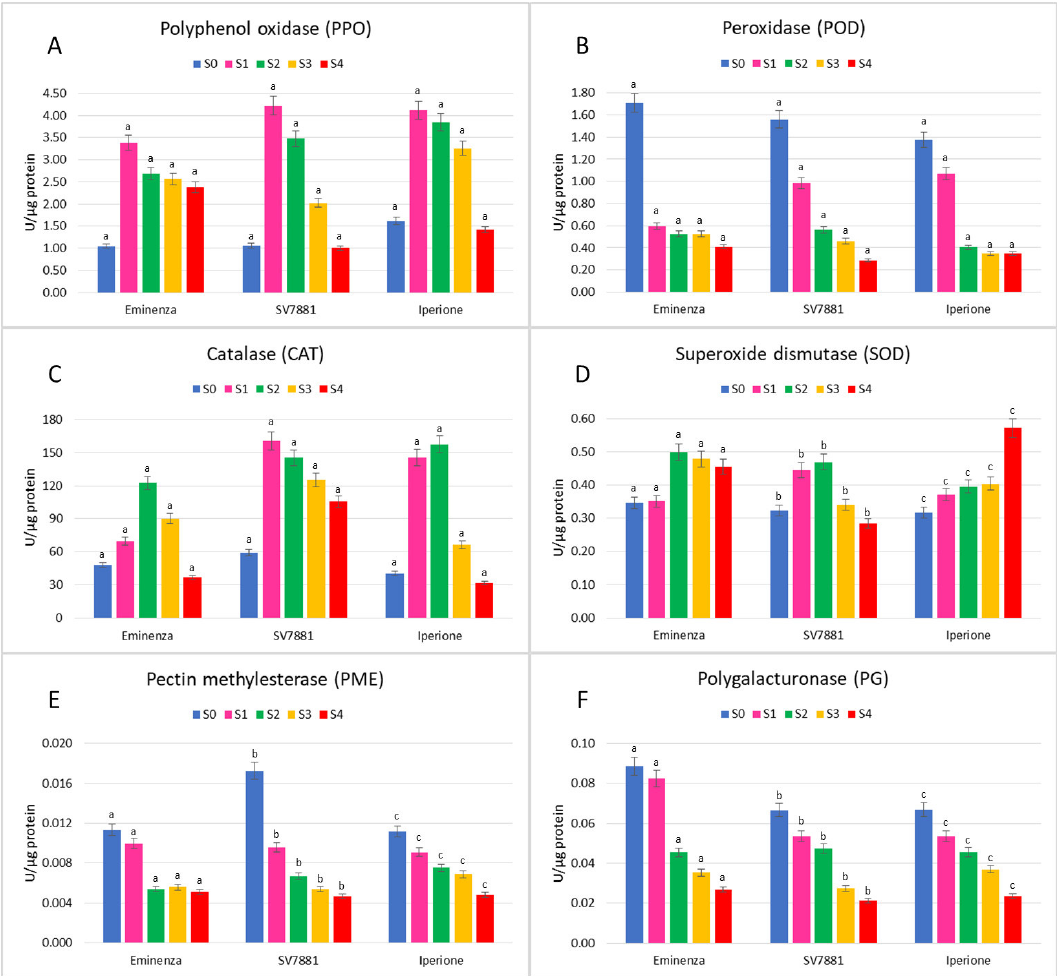
Figure 1. Enzymatic activities of Eminenza, SV7881, and Iperione melons at five ripening stages (S0-S4): ( A ) polyphenol oxidase (PPO); ( B ) peroxidase (POD); ( C ) catalase (CAT); ( D ) superoxide dismutase (SOD); ( E ) pectin methylesterase (PME); ( F ) polygalacturonase (PG). Results are expressed as mean ± standard deviation. The values with different superscripts (a, b, or c) in the same graph are significantly different (Tukey test, p ≤